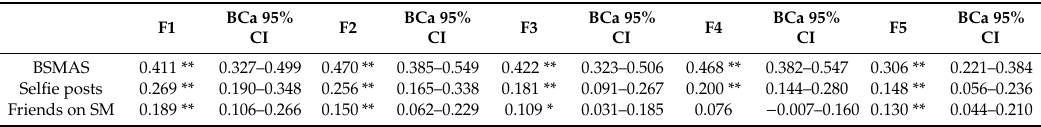
Table 4. Bootstrapped correlation matrix with 95% BCa confidence interval between the five dimensions of the SBS, BSMAS, number of selfies posts and number of friends on social media (Facebook, Twitter and Instagram). BCa 95% BCa 95% BCa 95% BCa 95% F1 F2 F3 F4 CI CI CI